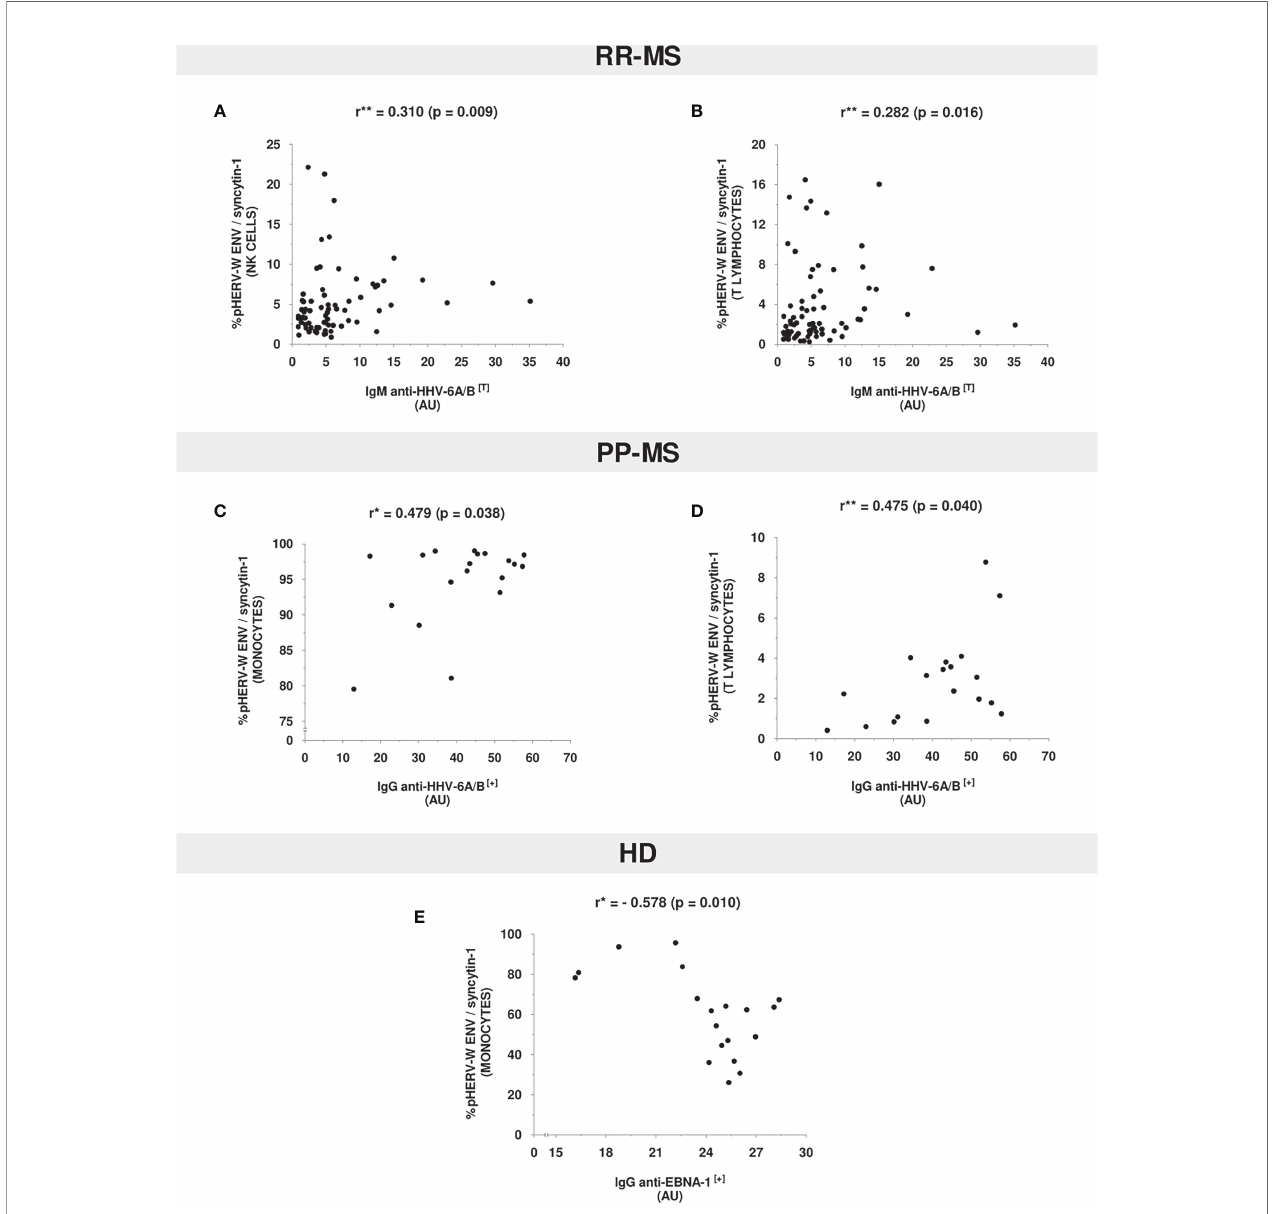
FIGURE 3 | Correlation plots between antiviral antibodies titers and pHERV-W ENV/syncytin-1 protein expression levels in (A, B) RR-MS patients, (C, D) PP-MS patients, and (E) HD. Only statistically signi fi cant correlations are shown. [*Pearson ’ s Correlation Coef fi cient; **Spearman ’ s Correlation Coef fi cient; (+), positive values ( ≥ 11 AU); (T), total values (positive&negative); AU, arbitrary